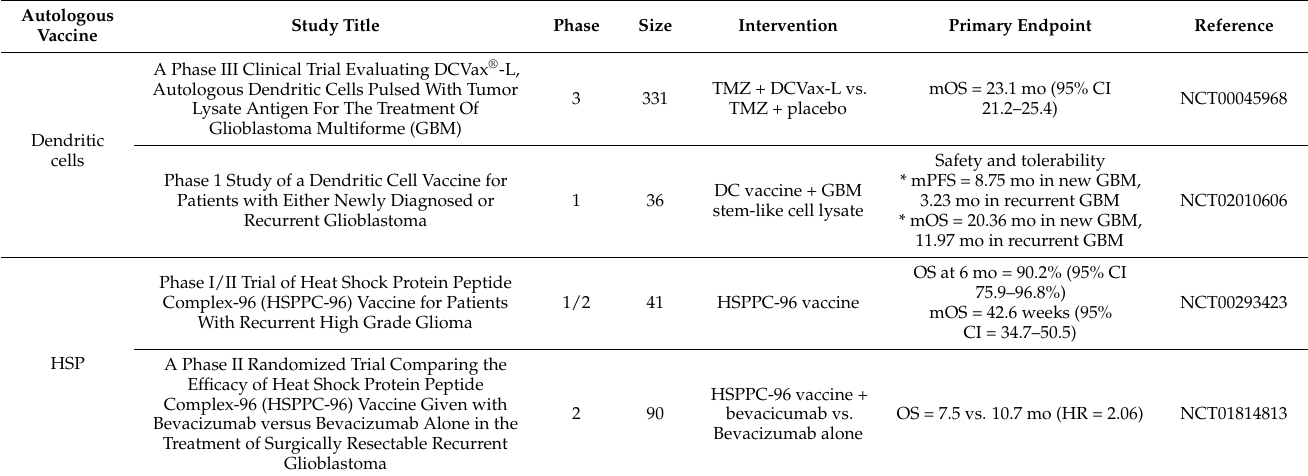
Table 2. Autologous vaccine clinical trials for